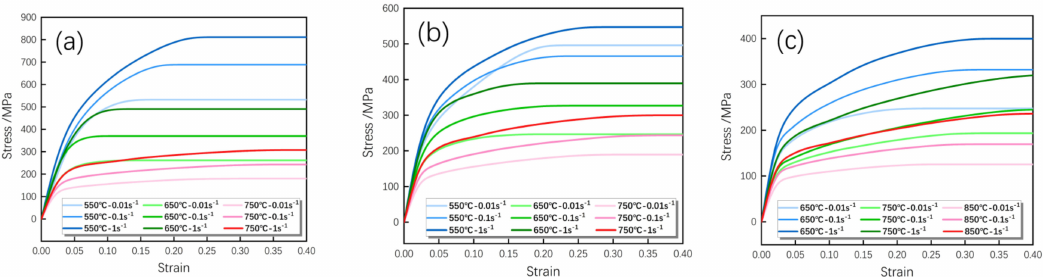
Figure 5. The stress-strain curves. ( a ) Group A TPP-F; ( b ) Group B TPP-S; ( c ) Group C hard regions.